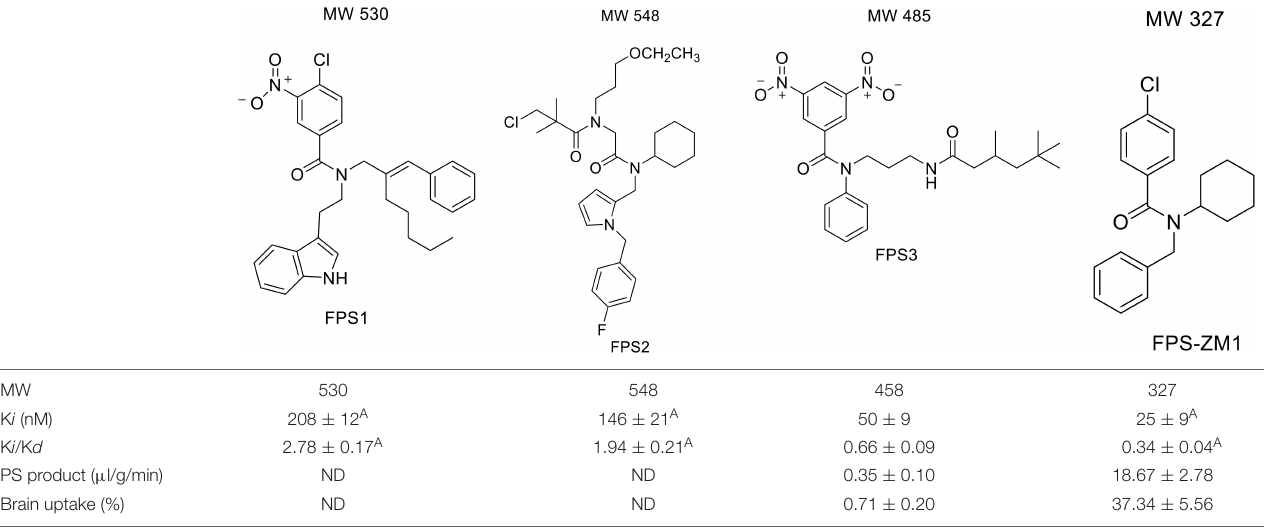
TABLE 1 | Features of FPS1-3 and FPS-ZM1.